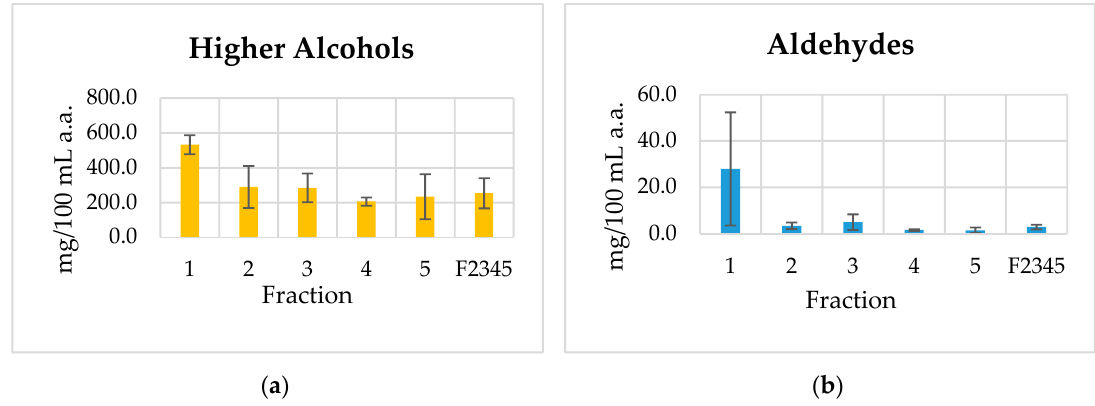
Figure 4. Concentration of higher alcohols ( a ) and aldehydes ( b ) in different collected fractions. Fraction 1 obtained in the continuous distillation system was equivalent to heads in the batch distillation and could be removed to obtain a final product with a better aromatic